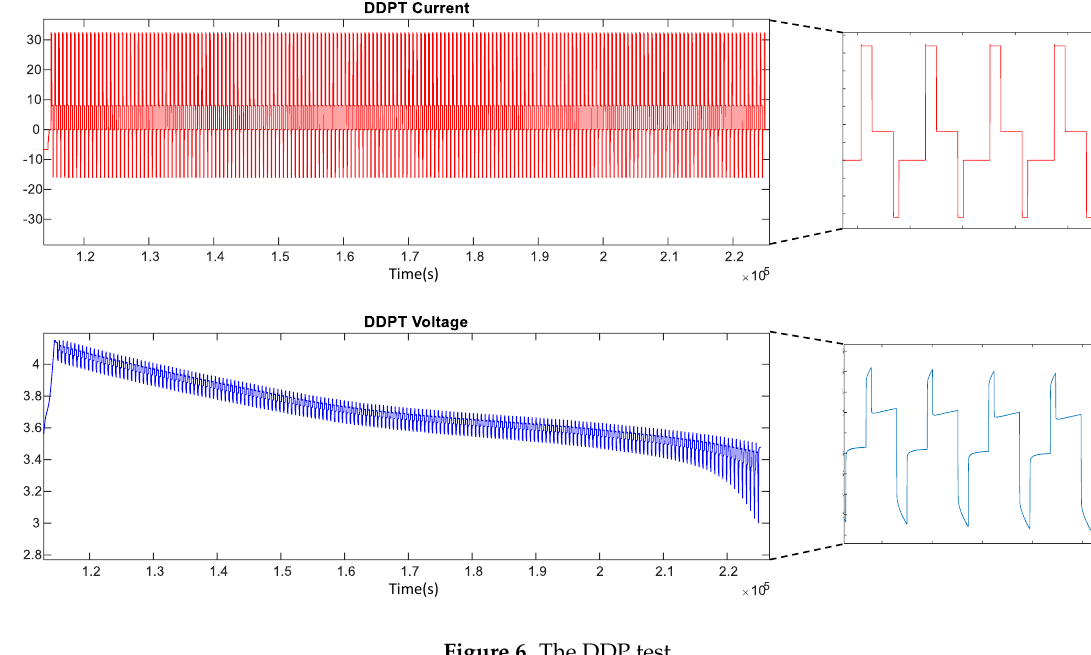
Figure 6. The DDP